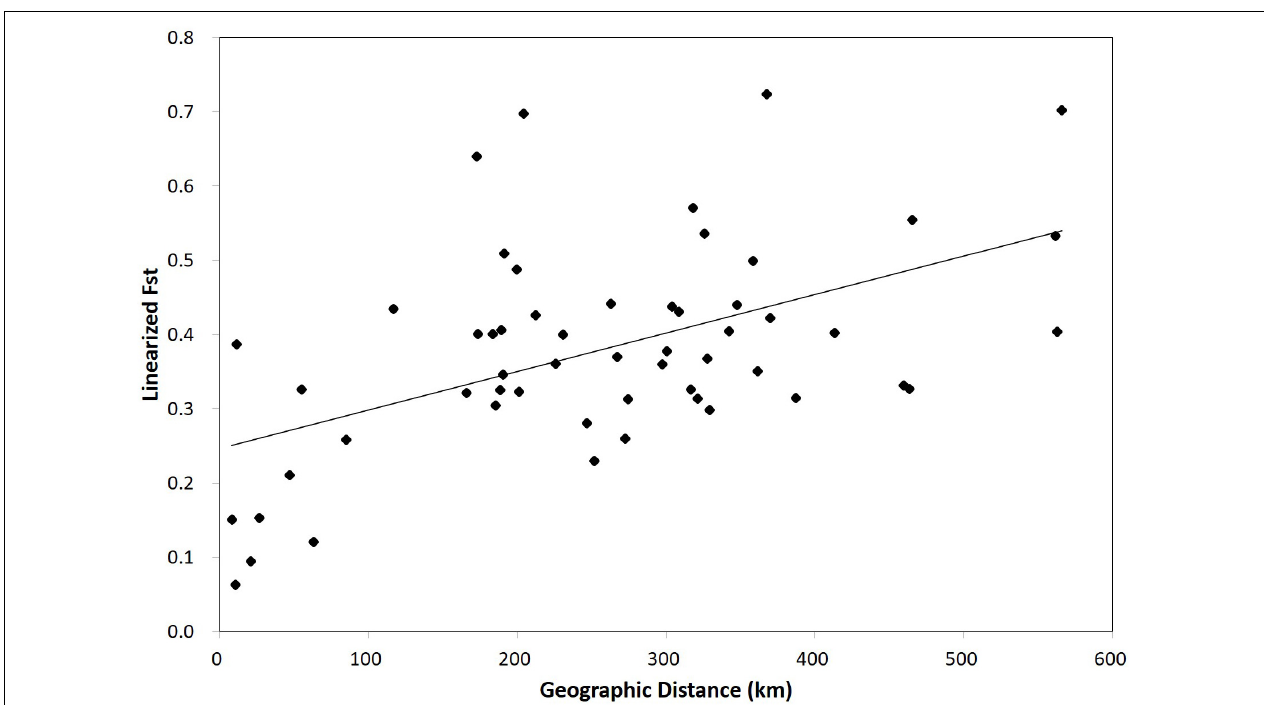
FIGURE 1 | A plot of the correlation between geographic distance (Euclidean) and F ST of 55 Habenaria linearifolia and Habenaria cruciformis population pairs in South Korea. A significant isolation by distance pattern was identified ( r = 0.52, P < 0.01).